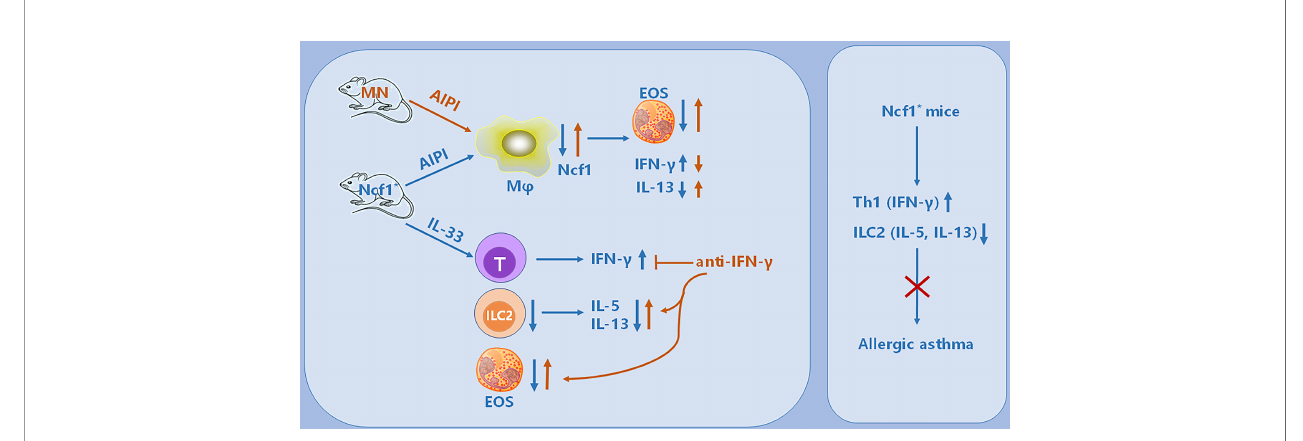
FIGURE 8 | Illustration of the immunoregulatory role of Ncf1 in pulmonary in fl ammation. In the OVA-induced AIPI model, Ncf1 de fi cient mice were protected from lung in fl ammation, with reduced eosinophil (EOS) in fi ltration, decreased IL-13 but increased IFN- g production. The MN mice, with alveolar macrophage-speci fi c Ncf1 restoration, showed the reversed in fl ammation severity, suggesting a residential macrophage-dependent immunoregulatory effect of Ncf1 in the lung in fl ammation. In addition, Ncf1 de fi cient mice stimulated with IL-33 showed reduced eosinophilic in fl ammation in the lung, with decreased ILC2 activation and increased IFN- g production, while anti- IFN- g antibody treatment to mice reversed disease severity and increased ILC2 activation. Our results indicate that Ncf1 de fi ciency enhanced Th1 response and deactivate ILC2, to protect against lung in fl ammation in